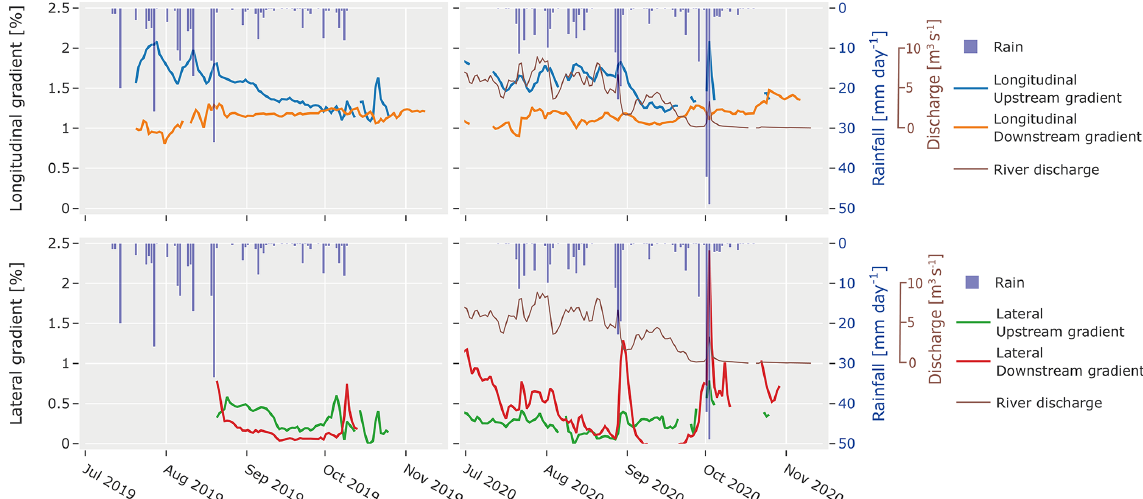
Figure 6. Groundwater gradients in the outwash plain for summers 2019 and 2020. The upstream longitudinal gradients are estimated between wells D1 and C1, the downstream gradient between C1 and B1. The lateral gradients are estimated between D wells upstream and B wells downstream, and their slope is directed towards the main river. In 2020, the mean daily discharge at the glacier outlet (GS1) is shown in brown and was scaled between 1% and 2% slope for easier comparison with the gradients. Daily measured rainfall at the glacier snout (weather station) are shown by inverted blue bars.